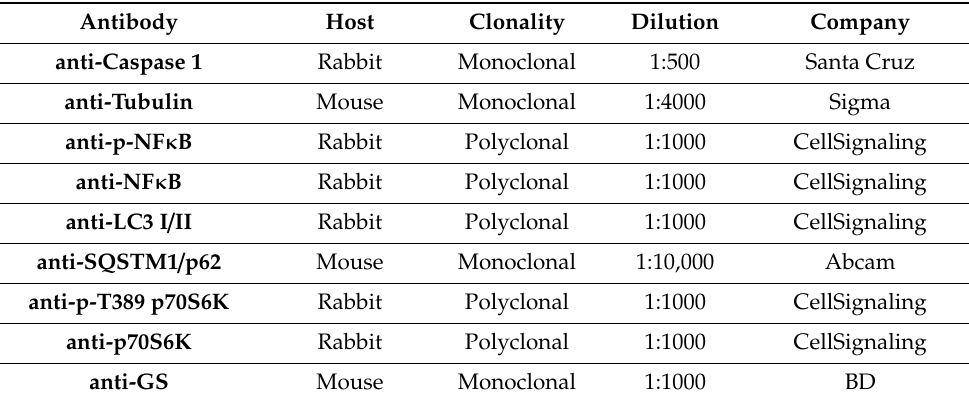
Table 1. Antibodies used for the western blot. Antibody Host Clonality Dilution